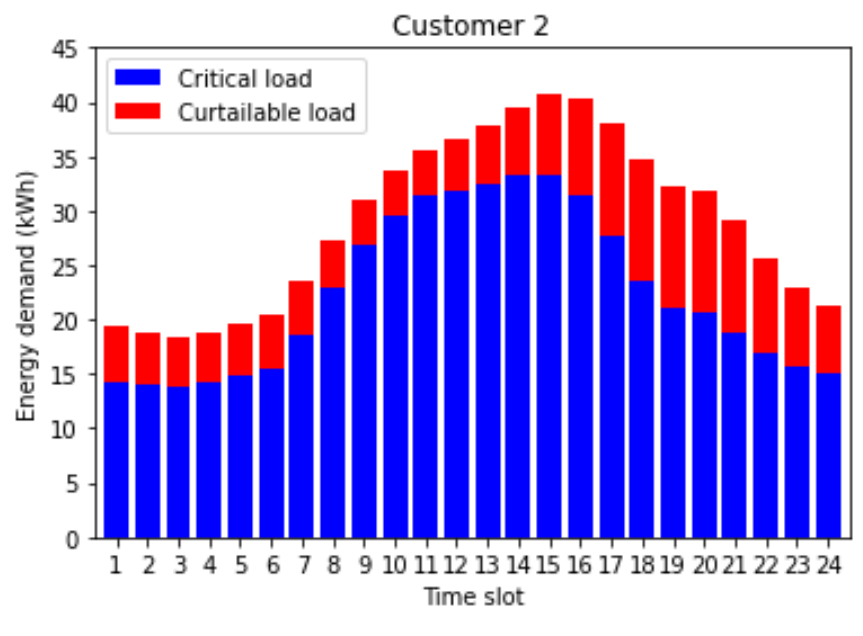
Figure 11. Critical and curtailable load for customer 2.